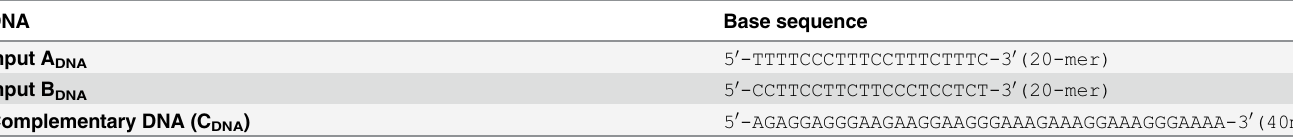
Table 1. Nucleotide sequences of A DNA , B DNA , and complementary DNA (C DNA ). DNA